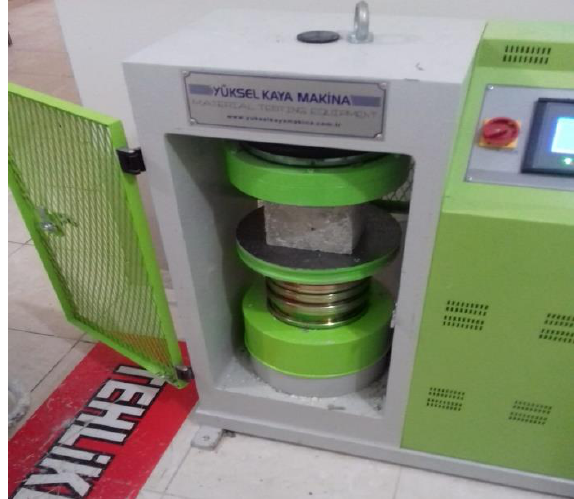
Figure 10. Appearance of samples in compressive strength tester.